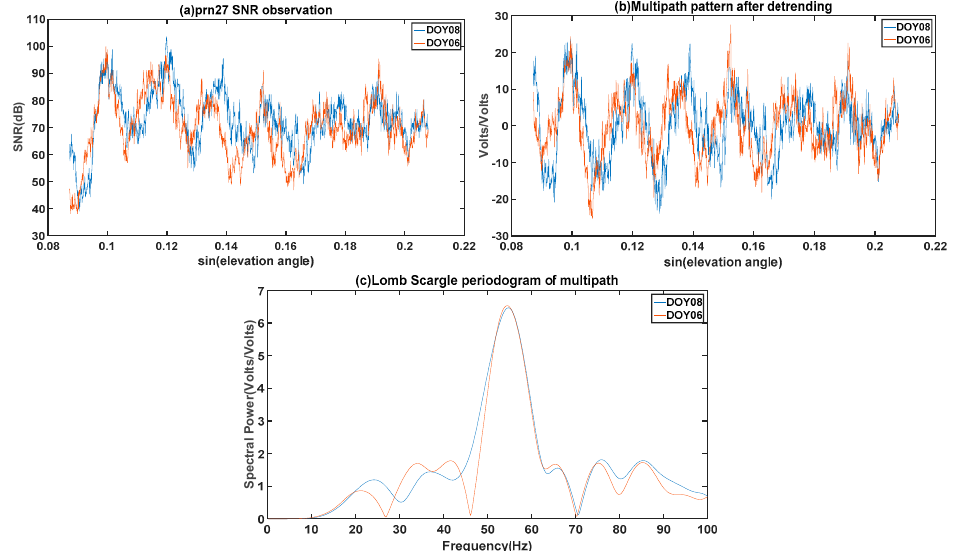
Figure 2. ( a ) GPS signal-to-noise ratio (SNR)1 observation at the SC02 GPS station; ( b ) multipath pattern after detrending; ( c ) Lomb–Scargle Periodogram for the PRN27 GPS satellite on 6 and 8 January 2015.